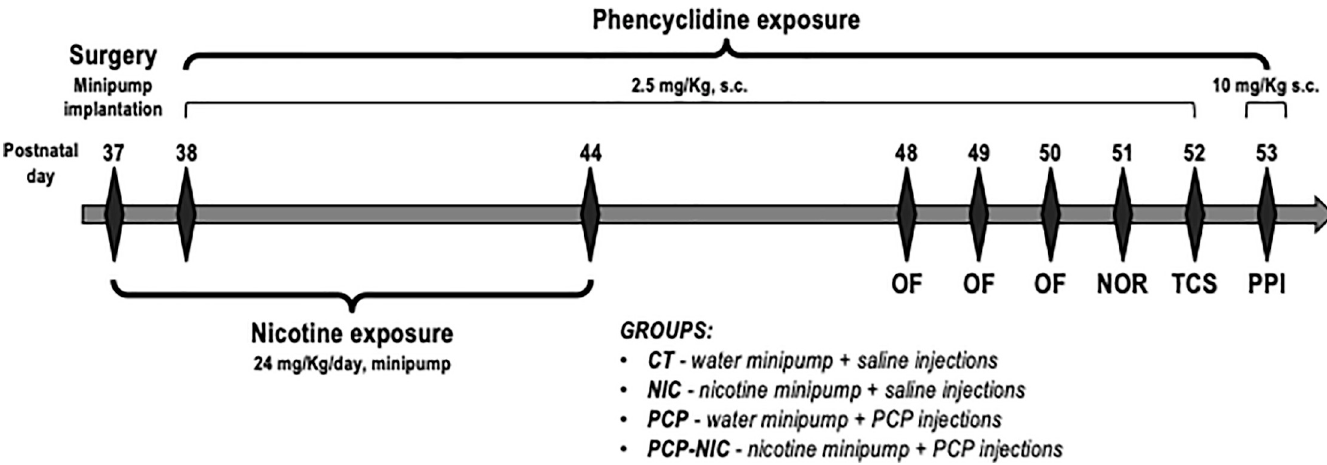
Fig 1. Timeline of experimental design. CT: Control group; NIC: Nicotine-exposed group; NOR: Novel Object Recognition test; OF: Open Field test; PCP: Phencyclidine-treated group; PCP-NIC: Phencyclidine-treated and nicotine-exposed group; PN: Postnatal day; PPI: Prepulse inhibition test; TCS: Three-Chamber Sociability